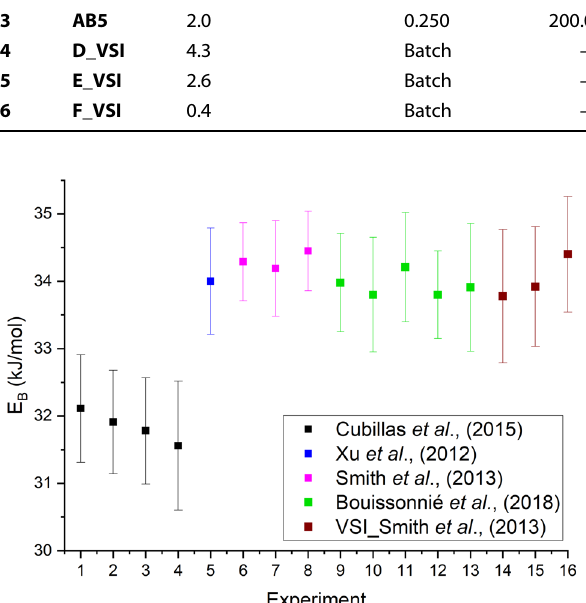
Fig. 6 Estimated bond-breaking activation energy for the 16 different experimental dissolution rate values. Average values are computed from the 200 optimizations (symbol) as the correspond- ing standard deviation (bars). Experiment numbers ( x -axis) are given in Table 5,